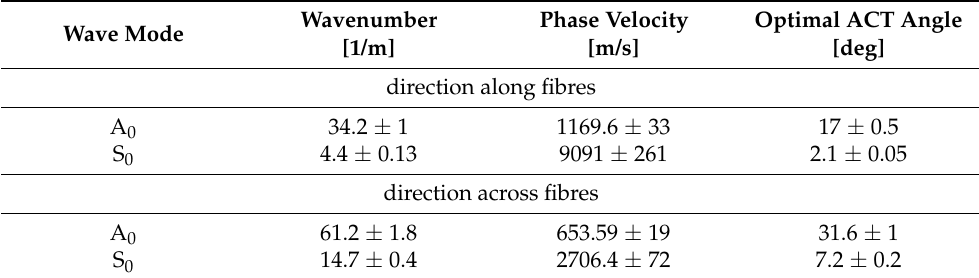
Table 2. Experimental results.